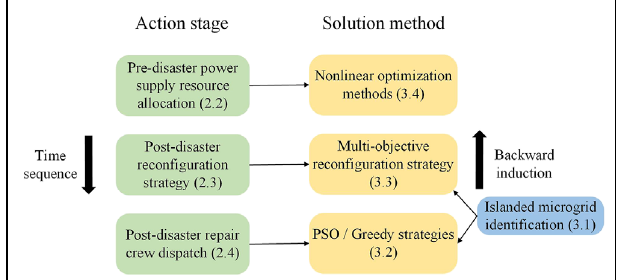
FIGURE 3 | Optimization models and their corresponding solution methods.